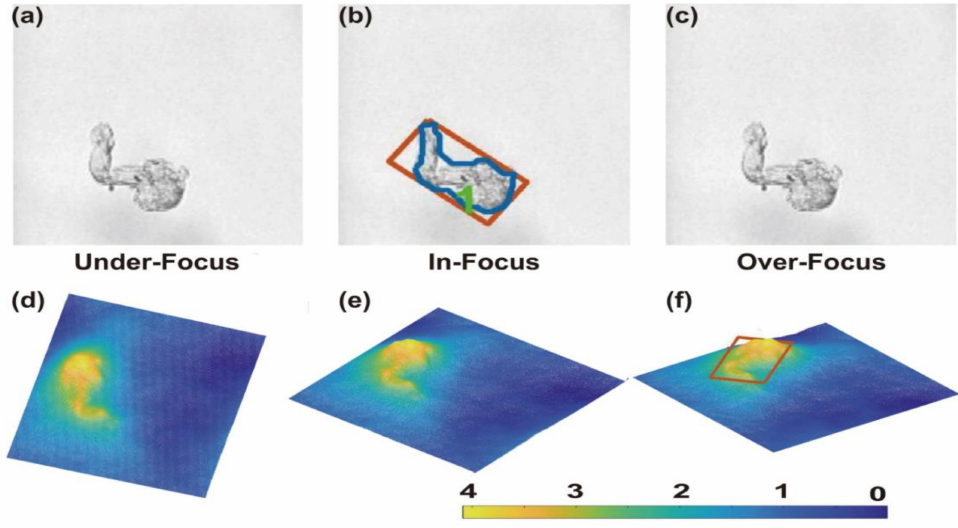
Figure 4. Image and phase distributions of cellulose particles: ( a – c ) images of cellulose particles at different focus lengths; ( b , f ) identification and localization of cellulose particles in the oil; ( d – f ) phase distribution from different angles.